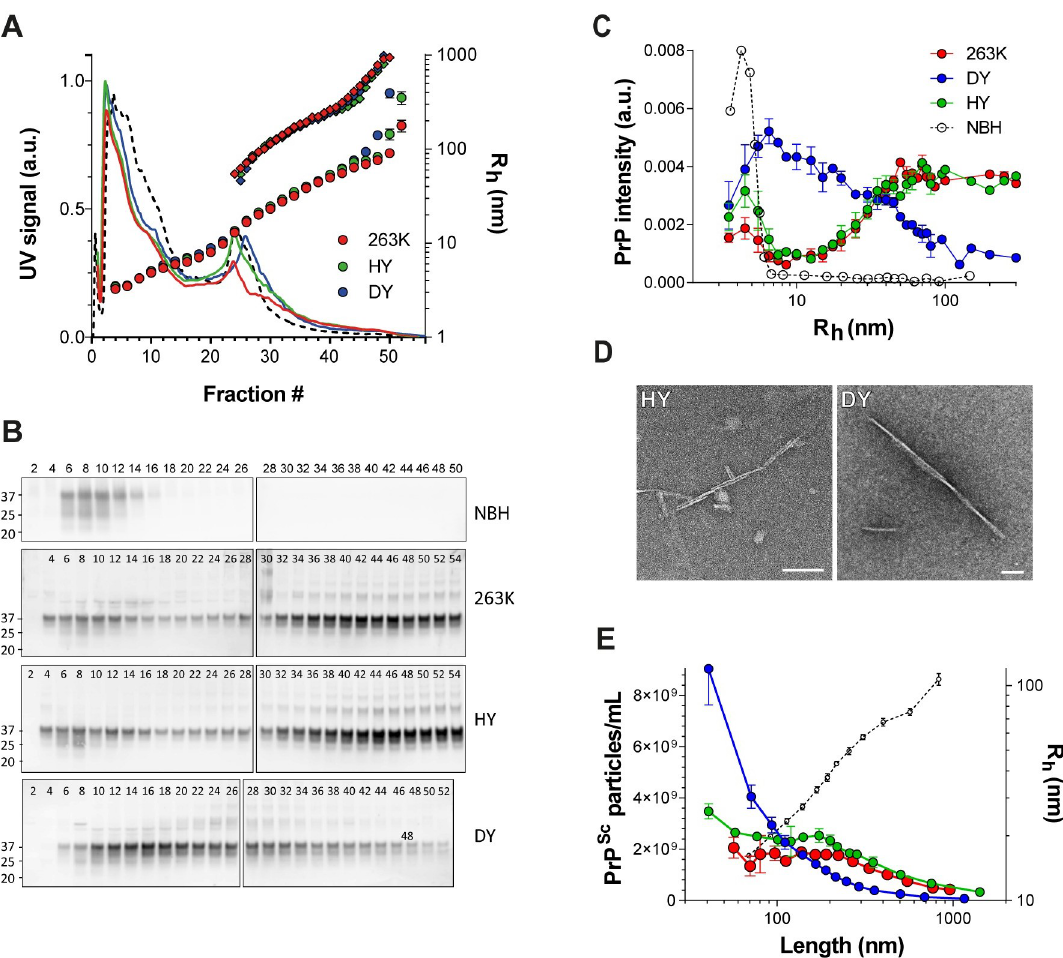
Fig 2. A) Representative fractograms of control (NBH, black dotted line), 263K (red), HY (green), and DY (blue) detergent- solubilized BHs. Solid curves: UV signal (protein content) at 280 nm; circles: R h (average ± SD) from thirty DLS measurements taken during the one-minute collection for each AF4 fraction; rhombus: particle length, calculated by fitting MALS signal to a rod-shape model. B) Representative immunoblots for PrP content in collected AF4 fractions; fractions from each brain homogenate were loaded in two polyacrylamide gels (gel 1: fraction 2 to 26/28, gel 2: fraction 28/30 to 50/54). SAF83 (dilution 1:10,000) was used as primary antibody. C) Size distributions of prion particles depicted as relative amount of PrP (from PrP immunoblot intensity; average ± SE) contributing to each particle size (R h (nm)). Non-infected (dotted line), 263K (red), HY (green), DY (blue). Three brains for each prion strain were analyzed and averaged. D) Electron micrographs of fractions #47 ( > 70 nm R h ) from HY (left) and DY (right) AF4 fractionation. No fibrillar particles were visible on the same fraction number from NBH fractionation. Bars = 100 nm. E) Density of PrP Sc particles (average ± SE) for each particle length. 263K (red), HY (green), DY (blue). The correlation between particle length and R h is shown as a black dotted